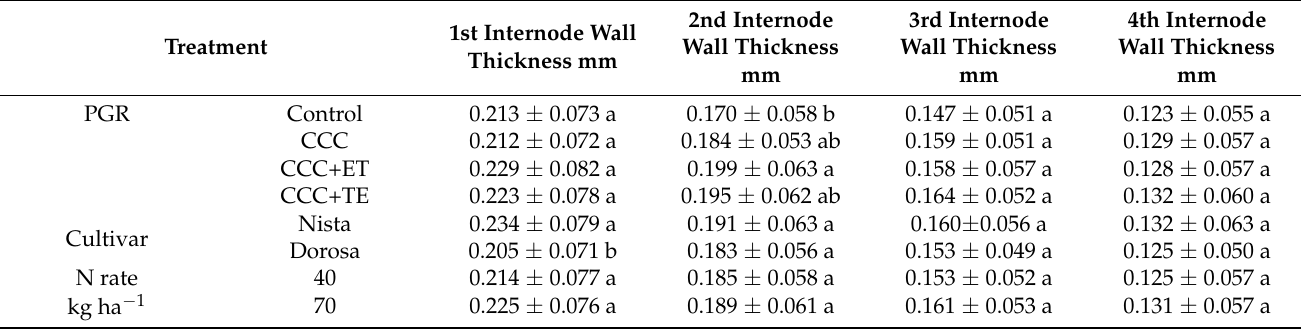
Table 5. Internode wall thickness of red fescue generative tillers ( Festuca rubra ssp. rubra cv. Nista and F . r . ssp. commutata cv. Dorosa), means for two production years, and two field